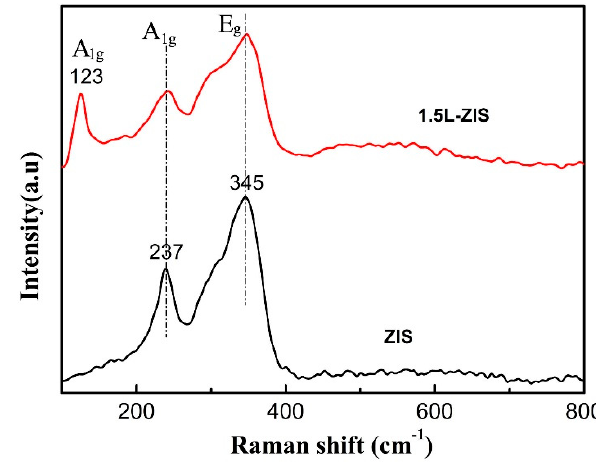
Figure 2. Raman spectra of P-ZIS and 1.5 at%-doped ZnIn 2 S 4 (1.5L-ZIS) samples.